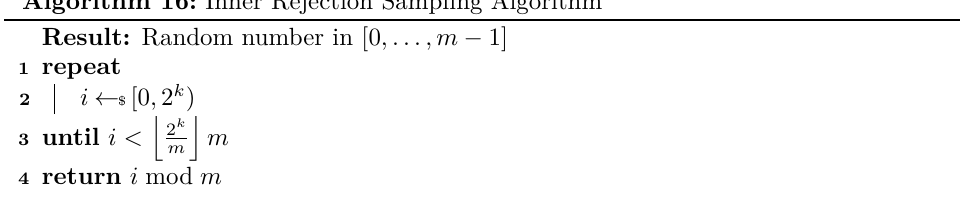
Algorithm 16: Inner Rejection Sampling